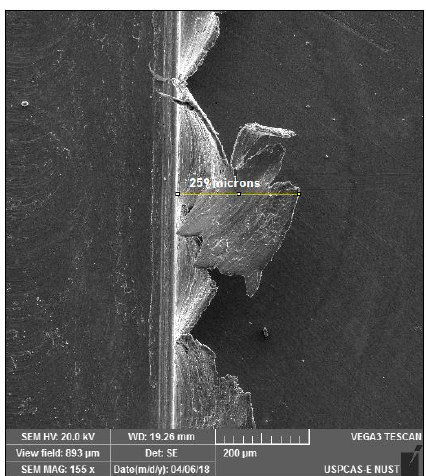
Figure 3. Burr width measurement ( a P = 30 µm, V C = 8 m/min, f Z = 0.2 µm/tooth, TiSiN).